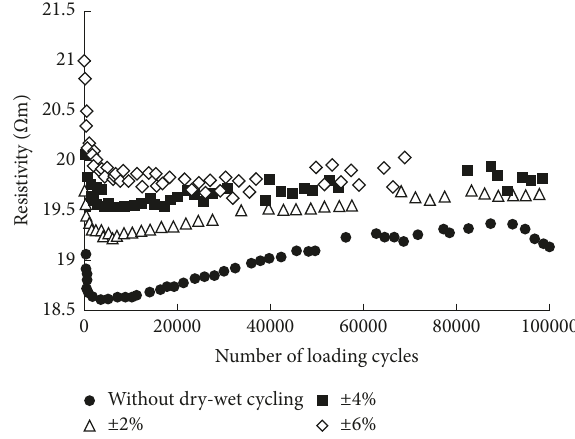
Figure 7: Effect of dry-wet cycling amplitudes on the soil sample